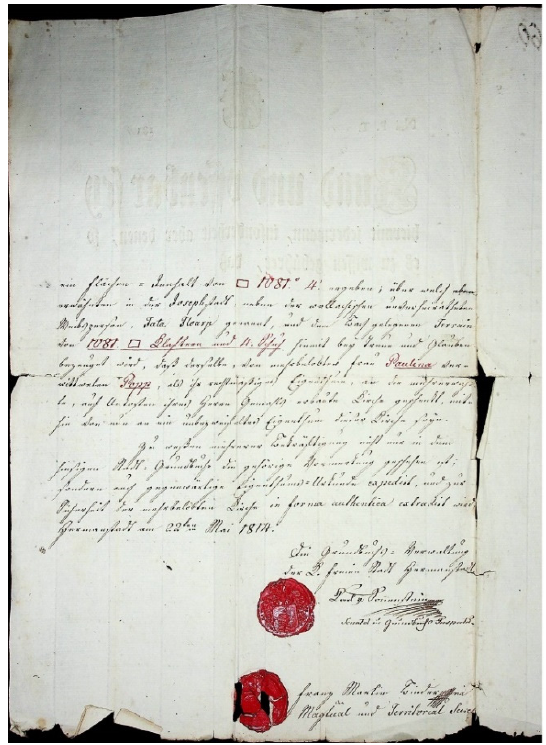
Figure 3. Second page of the document.